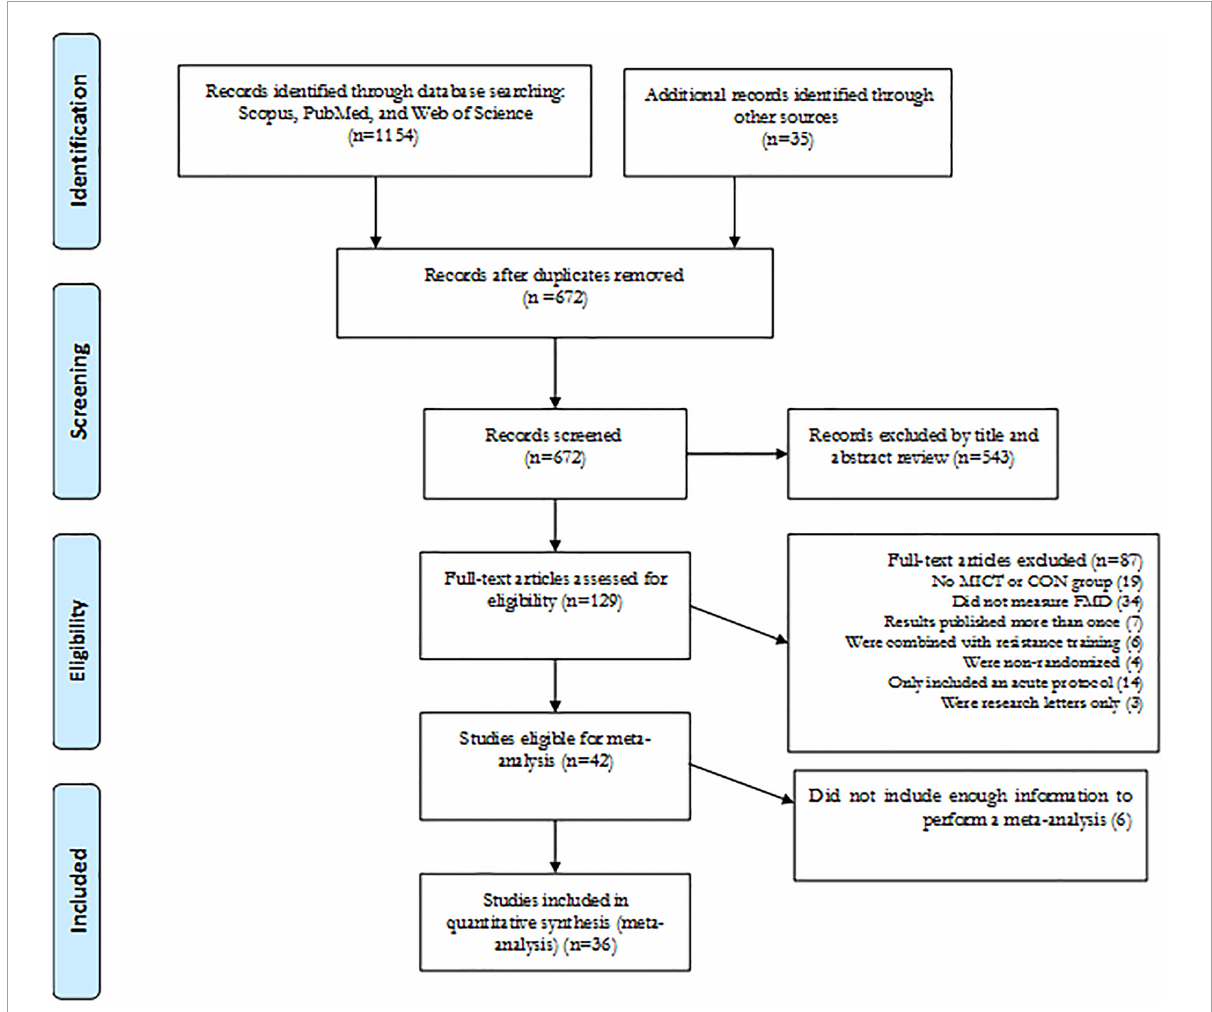
FIGURE1 Flow diagram of systematic literature search and article